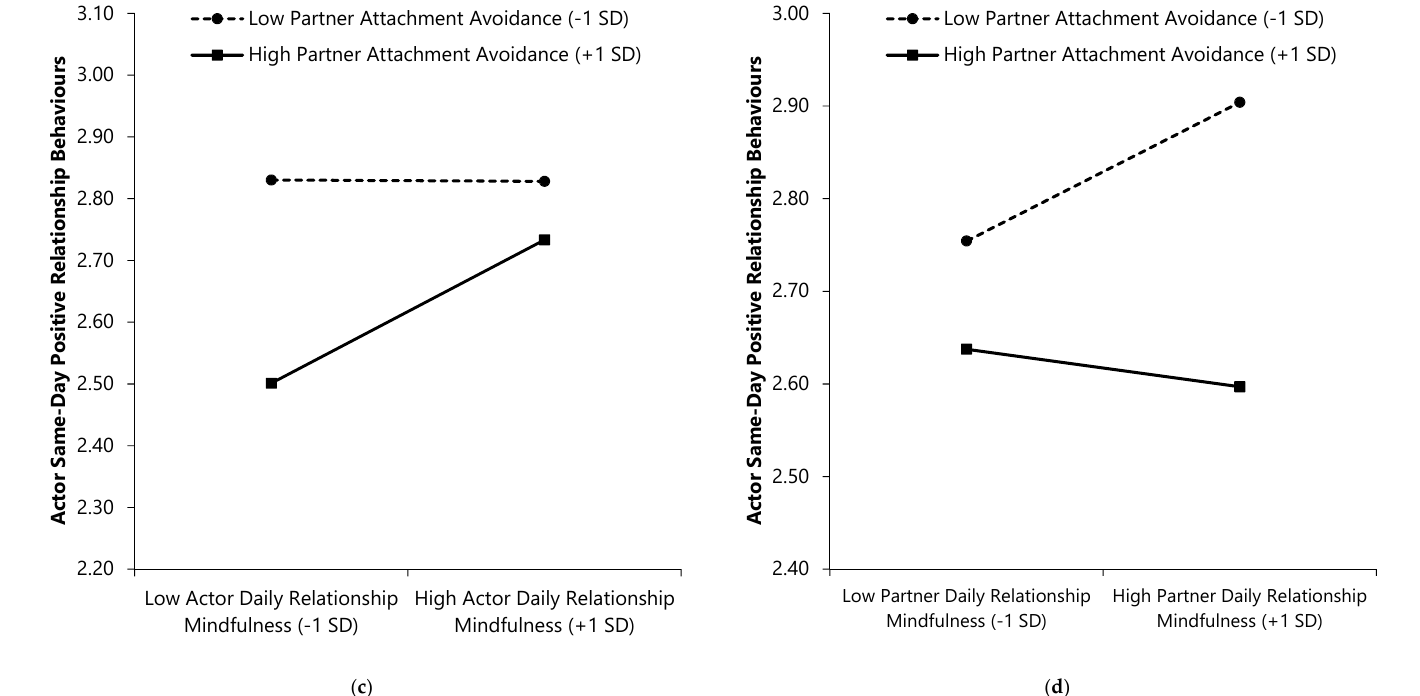
Figure 4. Interactions of attachment avoidance and daily relationship mindfulness with same-day positive relationship behaviours. ( a ) Actor × Actor interaction; ( b ) Actor × Partner interaction; ( c ) Partner × Actor interaction; ( d ) Partner × Partner interaction. Higher scores on continuous variables represent greater standing on the variable (e.g., higher daily RM).